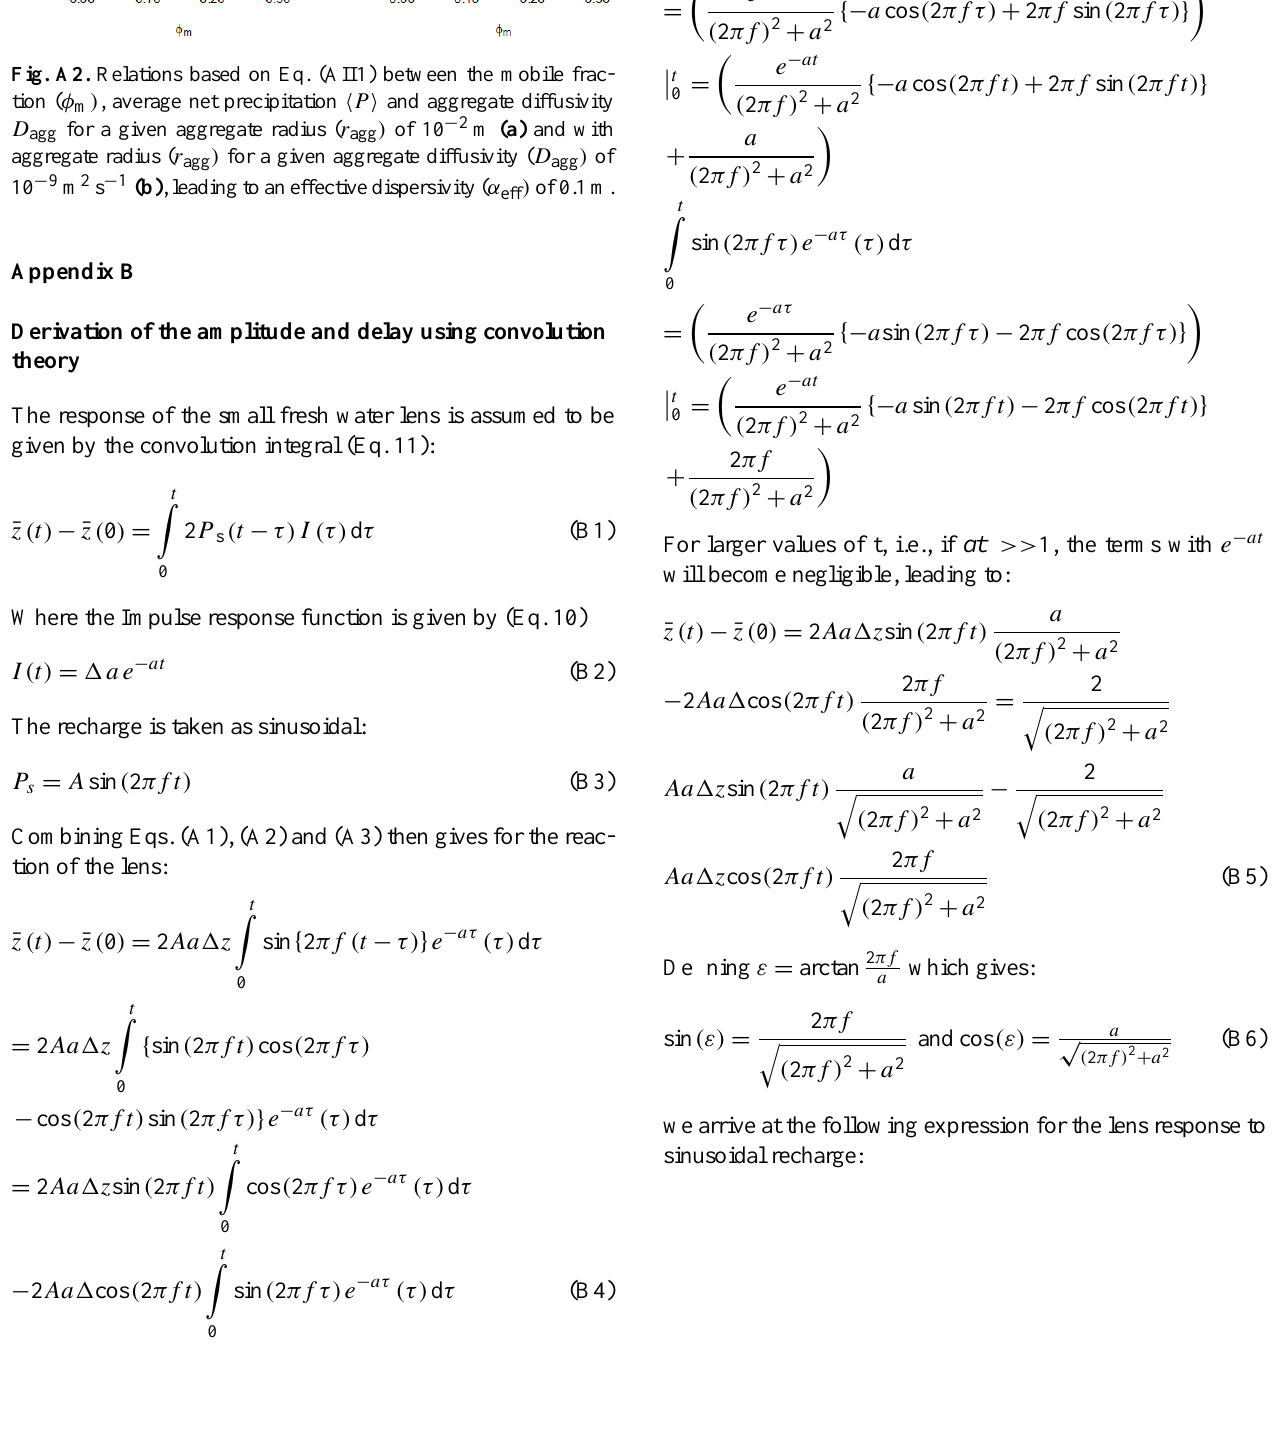
Fig. A2. Relations based on Eq. (AII1) between the mobile frac-